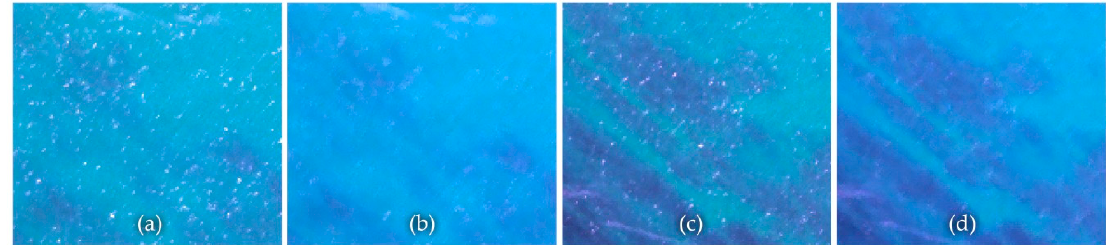
Figure 5. Influence of water anomaly filtering (WAF performance) on imagery quality at sites influenced by sun glint. True colour RGB (639 nm/550 nm/459 nm) for two example areas. Area 1 before filtering ( a ) and after filtering ( b ) and area 2 before filtering ( c ) and after filtering ( d ).